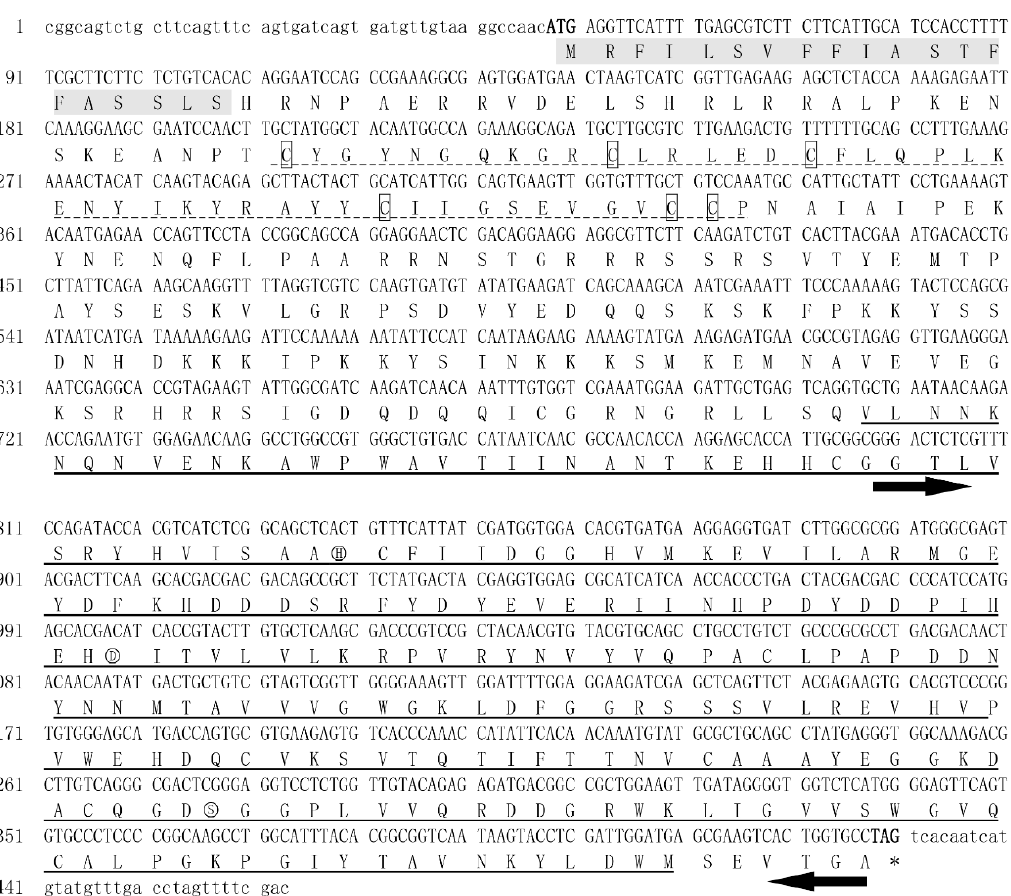
Figure 1. Nucleotide and deduced amino acid sequences of NlPCE3 . The start codon (ATG) and stop codon (TAG) are displayed in bold. The numbers on the left side of the figure correspond to the nucleotide sequence. Nl PCE3 is composed of a signal peptide (in shaded), a clip domain (dot-lined) with six cysteine (in box), and a trypsin-like serine proteinase domain (underlined). The catalytic triad is marked with a circle (H, D, and S). The template sequence for in vitro ds NlPCE3 synthesis was pointed (black